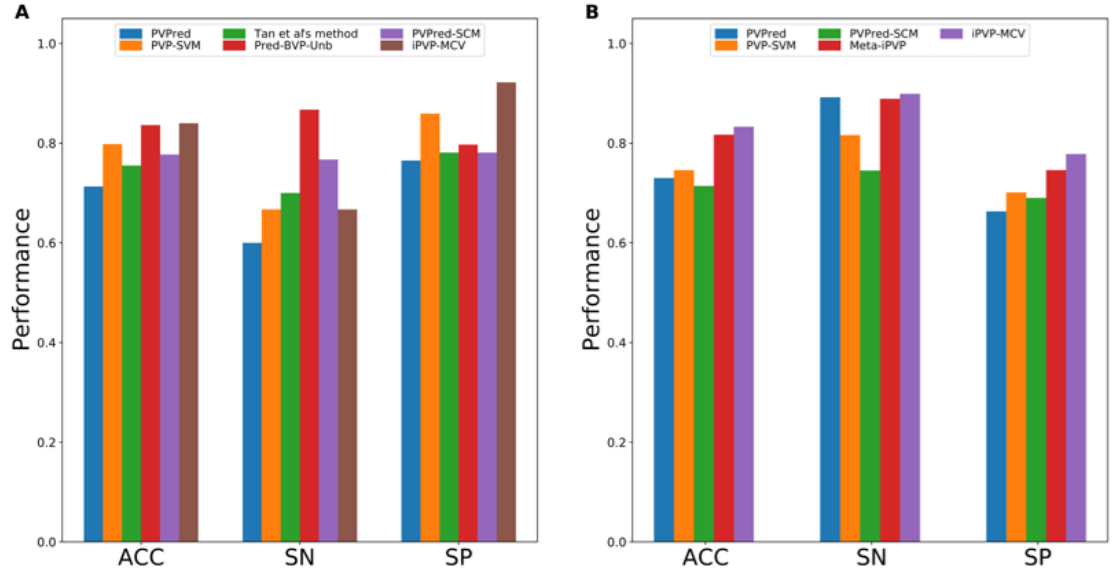
Figure 2: Performance evaluation on Manavalan2018 ( A ) and Charoenkwan2020_2.0 ( B ) datasets as deduce from independent